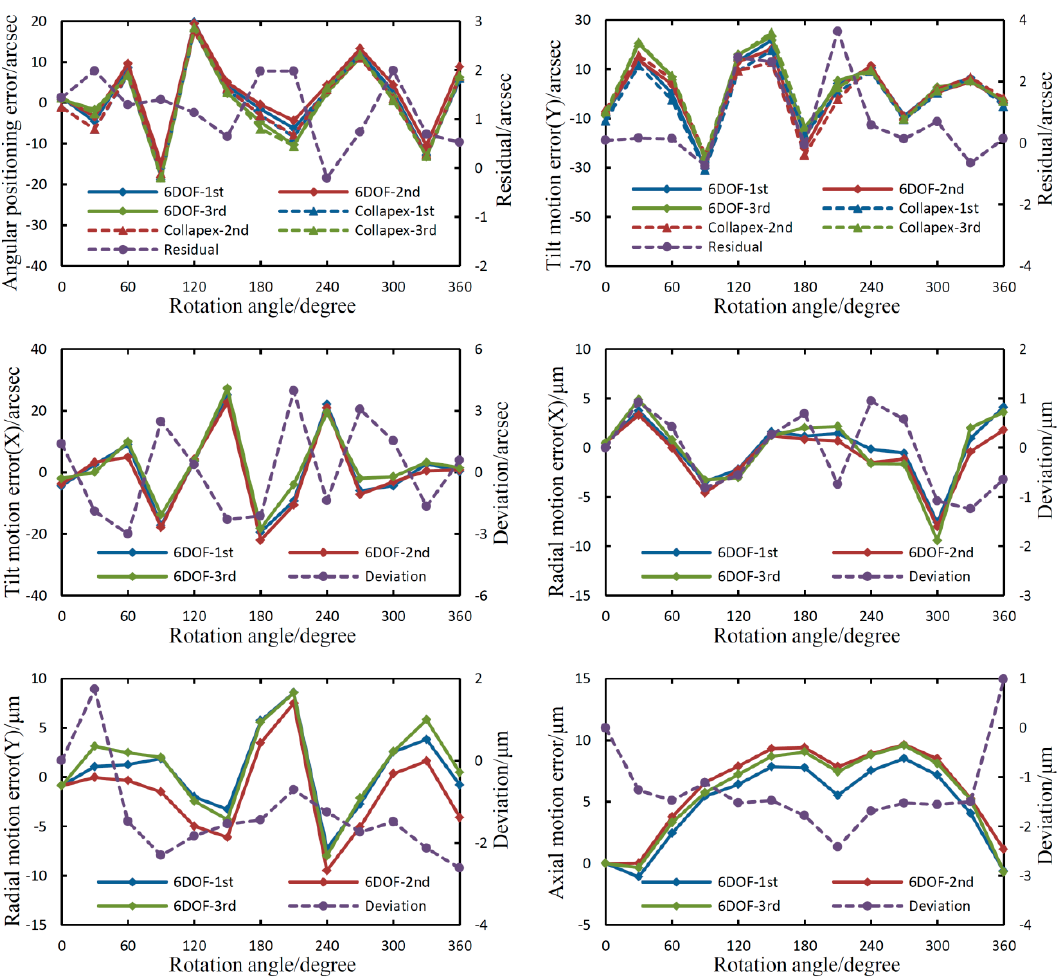
Figure 8. Results of repeatability tests and comparison experiments.